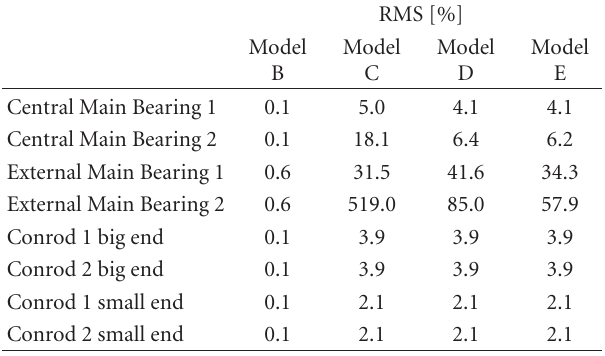
Table 1: RMS values of the relative percentage deviations with respect to Model